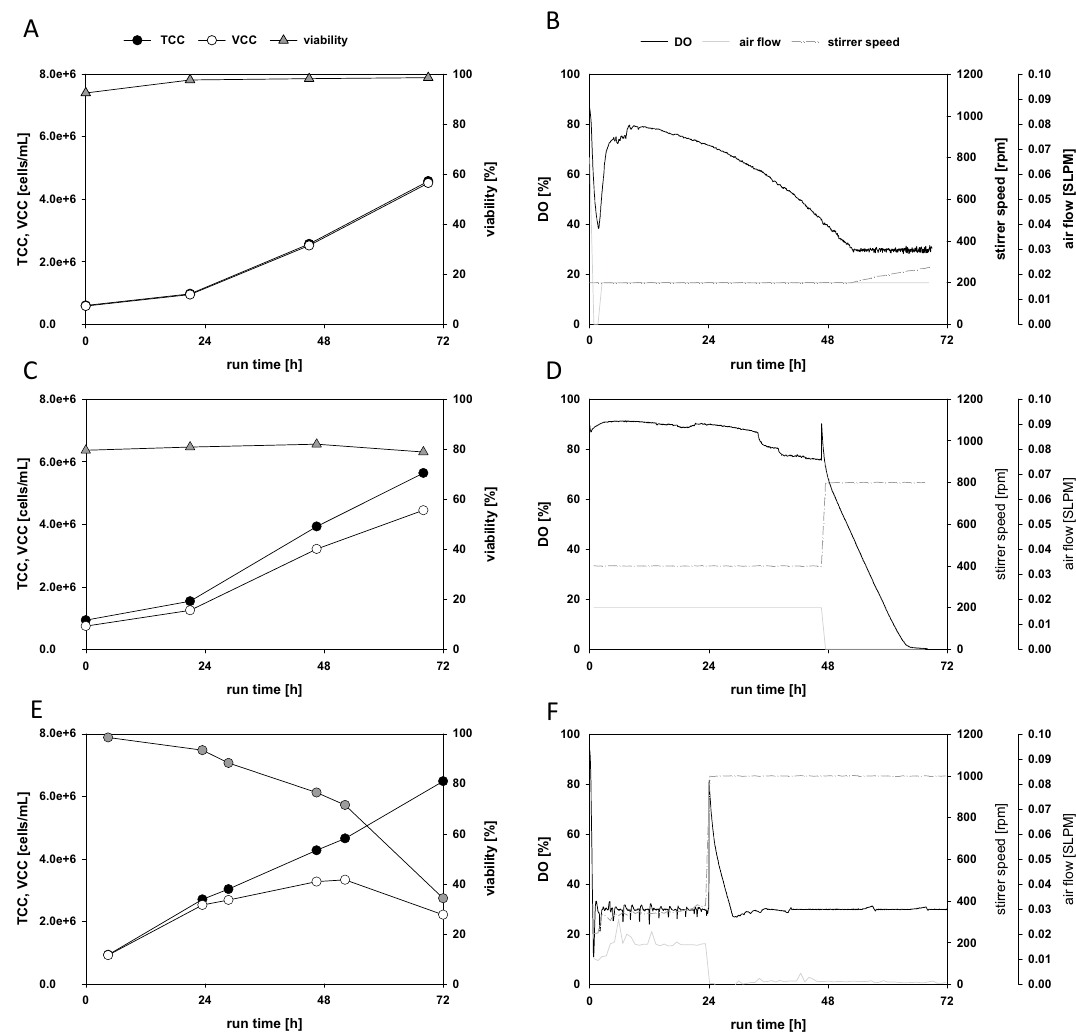
Figure 4. Batch fermentation of TN42 insect cells in a microbial bioreactor, at high stirring speeds. Bioreactors were equipped with either one Rushton impeller ( A , D ) or 3 levels of impellers ( E , F ). (Left column) Viability (triangles), and counts of total cells (TCC, filled circles) and viable cells (VCC, open circles) in the batch cultivation; (right column) the corresponding dissolved oxygen (DO, black solid line), stirring speed (dotted line), and air flow (grey solid line). Stirring speeds were ( A , B ) 200 rpm, incrementally increased to 270 rpm; ( C , D ) 400 rpm, stepped to 800 rpm at 48 h; ( E , F ) 400 rpm, stepped to 1000 rpm at 24